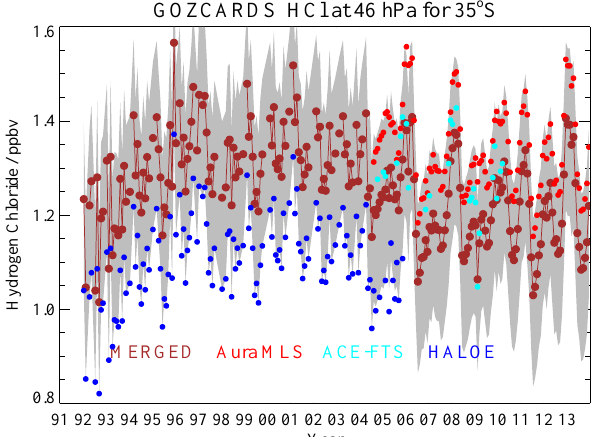
Figure 5. Illustration of GOZCARDS HCl monthly averages with systematic error estimates (grey shading) at 46hPa for 30–40 ◦ S; see text for the meaning of this shaded region. The source data from HALOE, Aura MLS, and ACE-FTS are shown in different colors (see legend), along with the merged